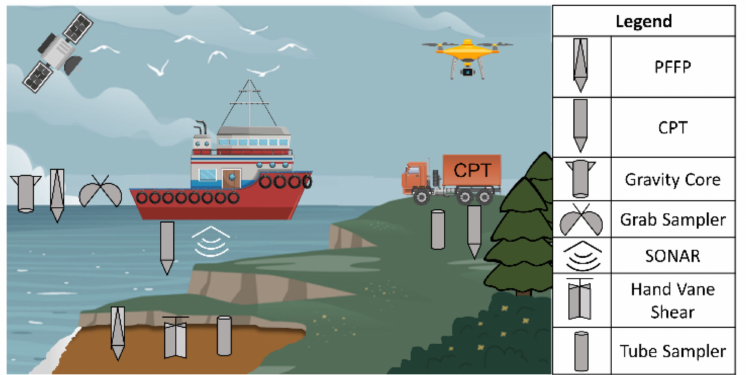
Figure 4. Conceptual sketch of combined data collection strategies for optimized coastal geotechnical site characterization in Arctic